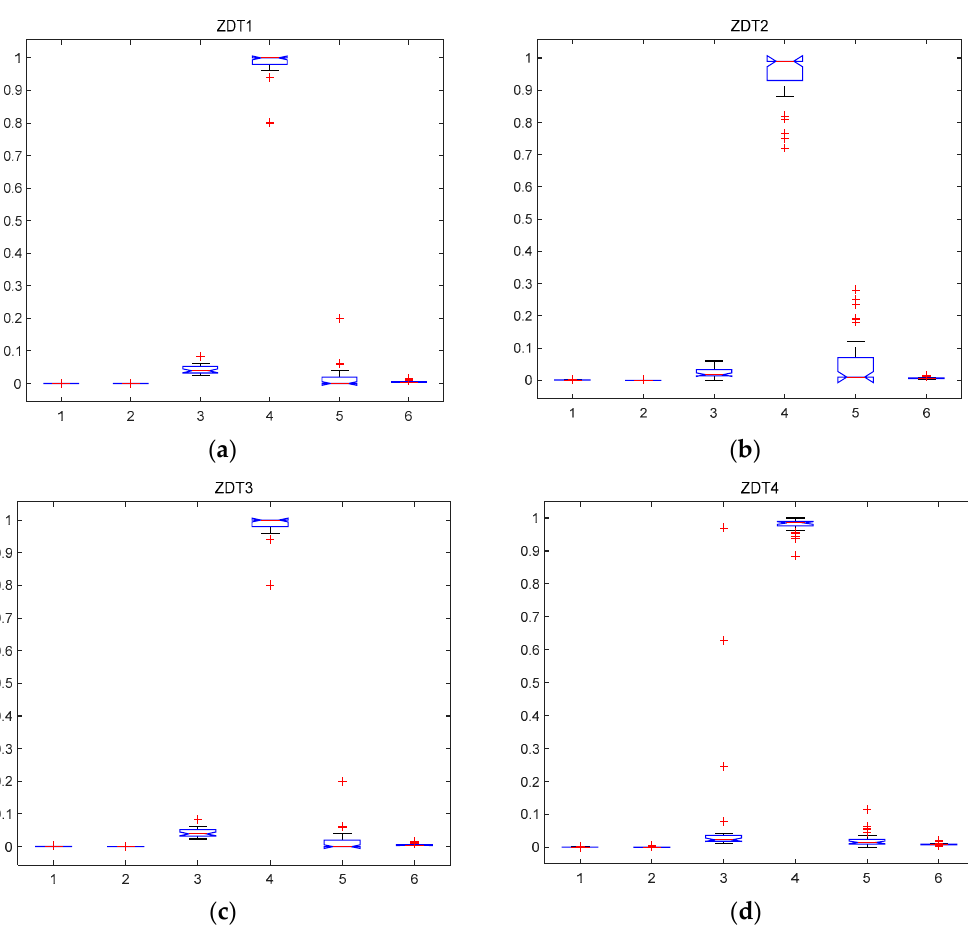
Figure 1. Box plot representing the distribution of the metrics on ZDT test problems (GD = 1, standard deviation of GD = 2, SP = 3, CR = 4, ER = 5 and γ = 6). ( a ) the metrics on ZDT1 problem; ( b ) the metrics on ZDT2 problem; ( c ) the metrics on ZDT3 problem; ( d ) the metrics on ZDT4 problem.